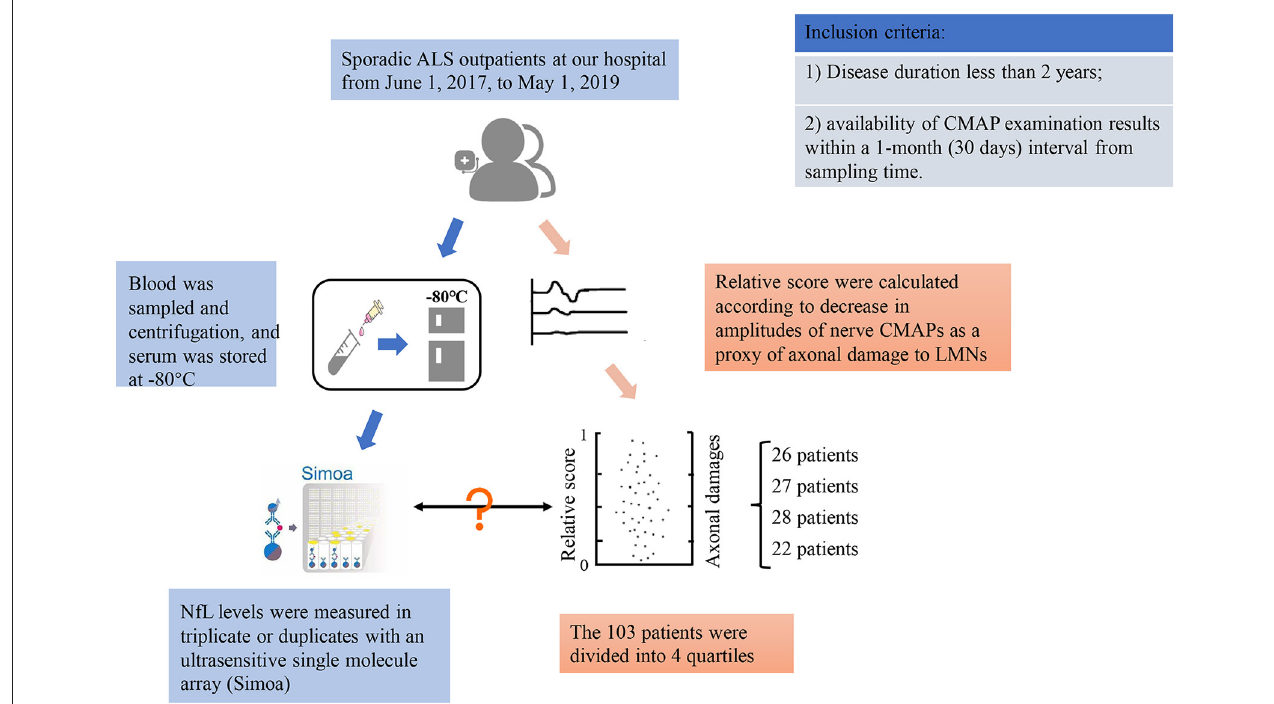
FIGURE 1 | Study flow